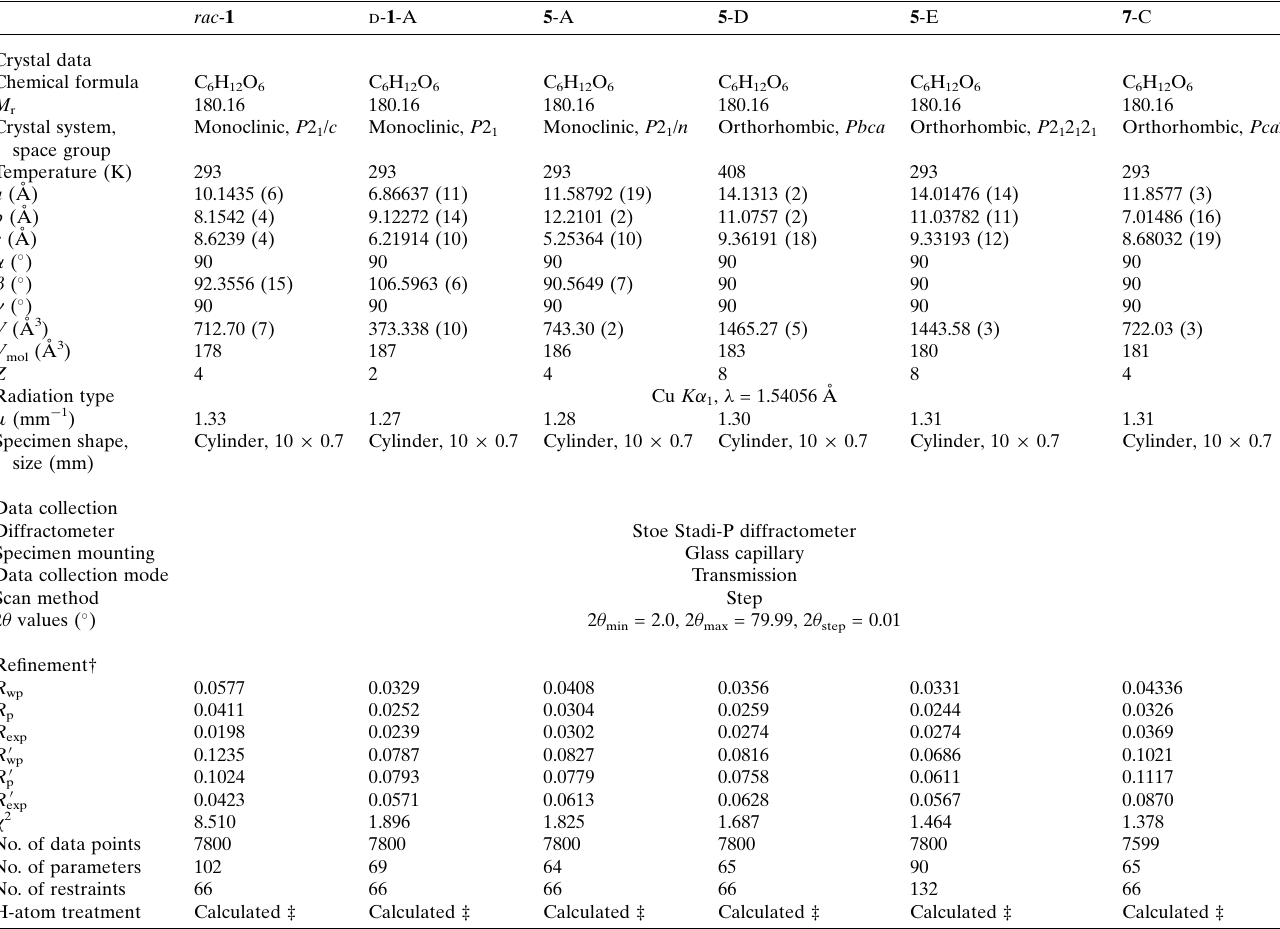
Table 2 Crystallographic data for the structures determined from X-ray powder diffraction data.